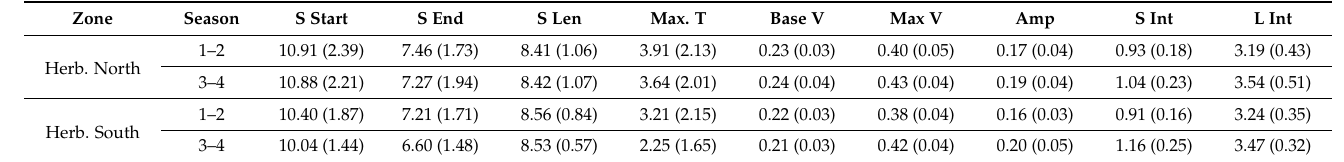
Table 2. Median values (and median absolute deviation) of the phenology and productivity metrics extracted from the TIMESAT fitted curve. Values are shown for the main vegetation types in each sector and for the first (Season 1–2) and second (Season 3–4) time intervals. Season start time (S start), season end time (S end), season length (S len), and the time of maximum NDVI (Max T) are measured in months (from 1 to 12, where a value of 1 corresponds with 1 January, and a value of 12 to 31 December). Seasonal base value (Base V), seasonal maximum value (Max V) and seasonal amplitude (Amp) correspond to NDVI values. Small Integral (S int) and large integral (L int) are the integrated values of the area under the NDVI